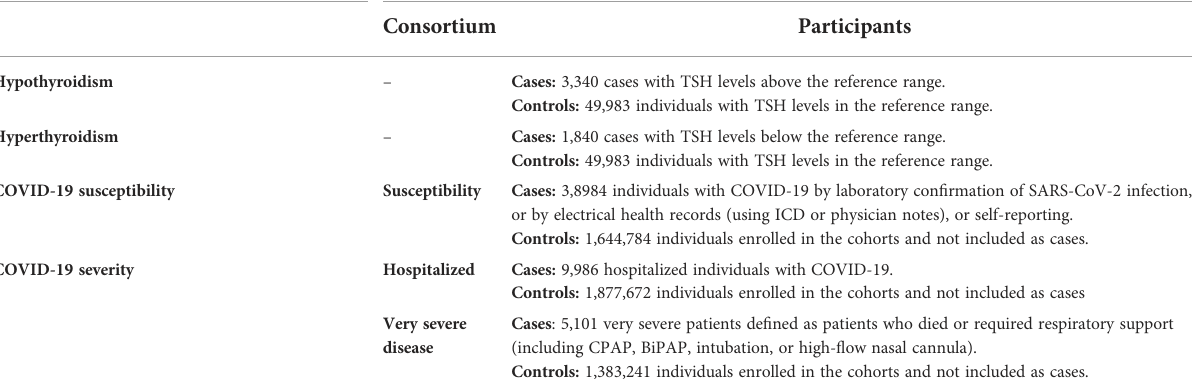
TABLE 1 Sources of data for the